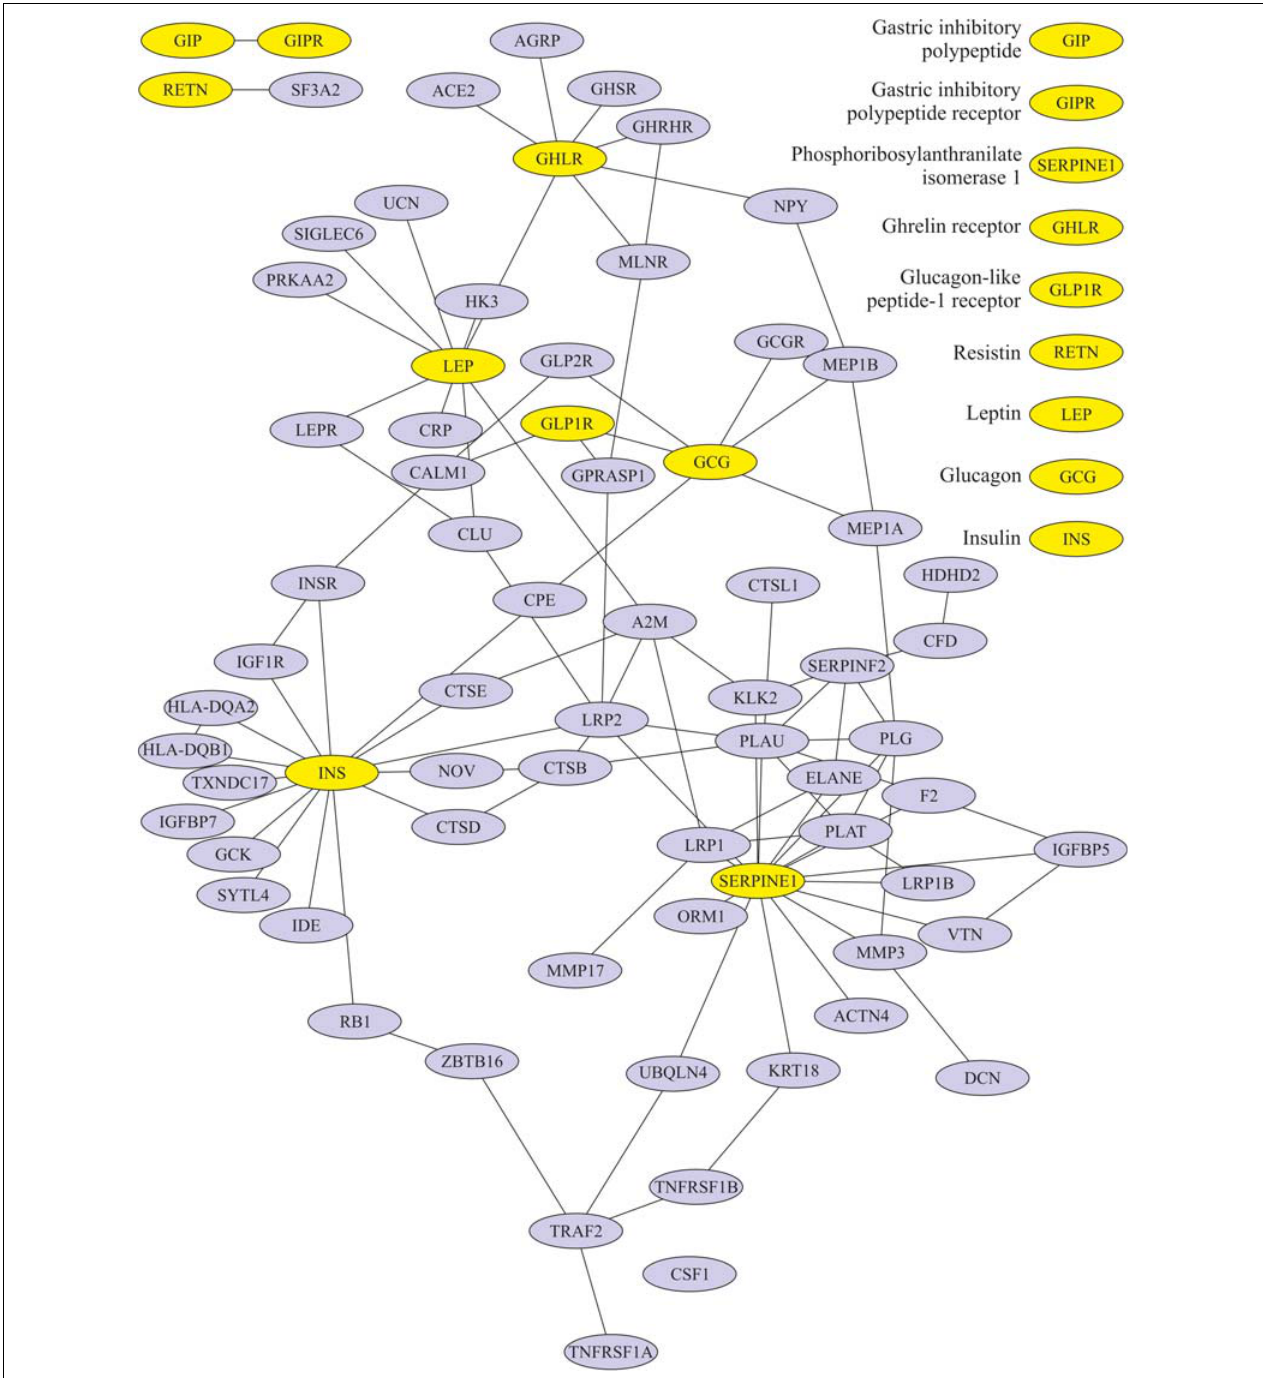
FIGURE 4 | Subnetwork of the proteins insulin, ghrelin, glucagon-like peptide-1 (GLP-1), leptin, and their nearest neighbors. Light nodes represent the proteins under study; dark nodes are their nearest neighbors.